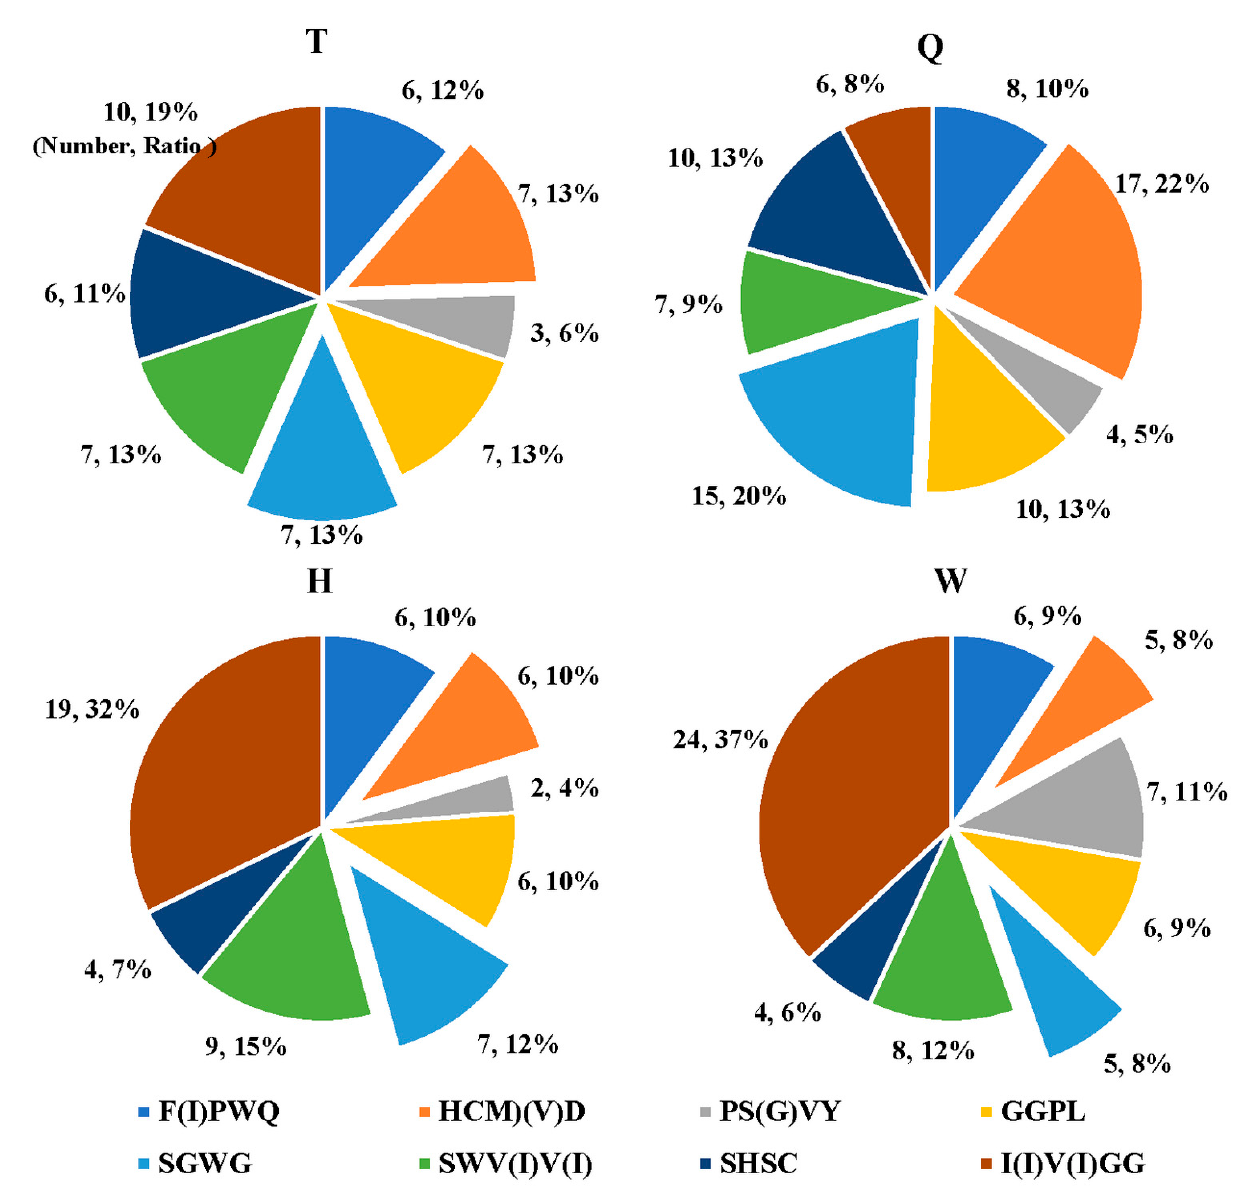
Figure 4. The number and ratio of target amino acid residues in T, Q, H, and W samples (The meanings of T, Q, H, and W are the same as those in Figure 3). The raw data were performed using Thermo Scientific Proteome Discoverer™ 2.2 software. MS/MS spectra were searched in the theoretical pheretima protein database obtained by transcriptomics (including 240,102 proteins). We detected 53, 77, 59, and 65 target peptides with shotgun proteomics from T, Q, H, W samples of PA,